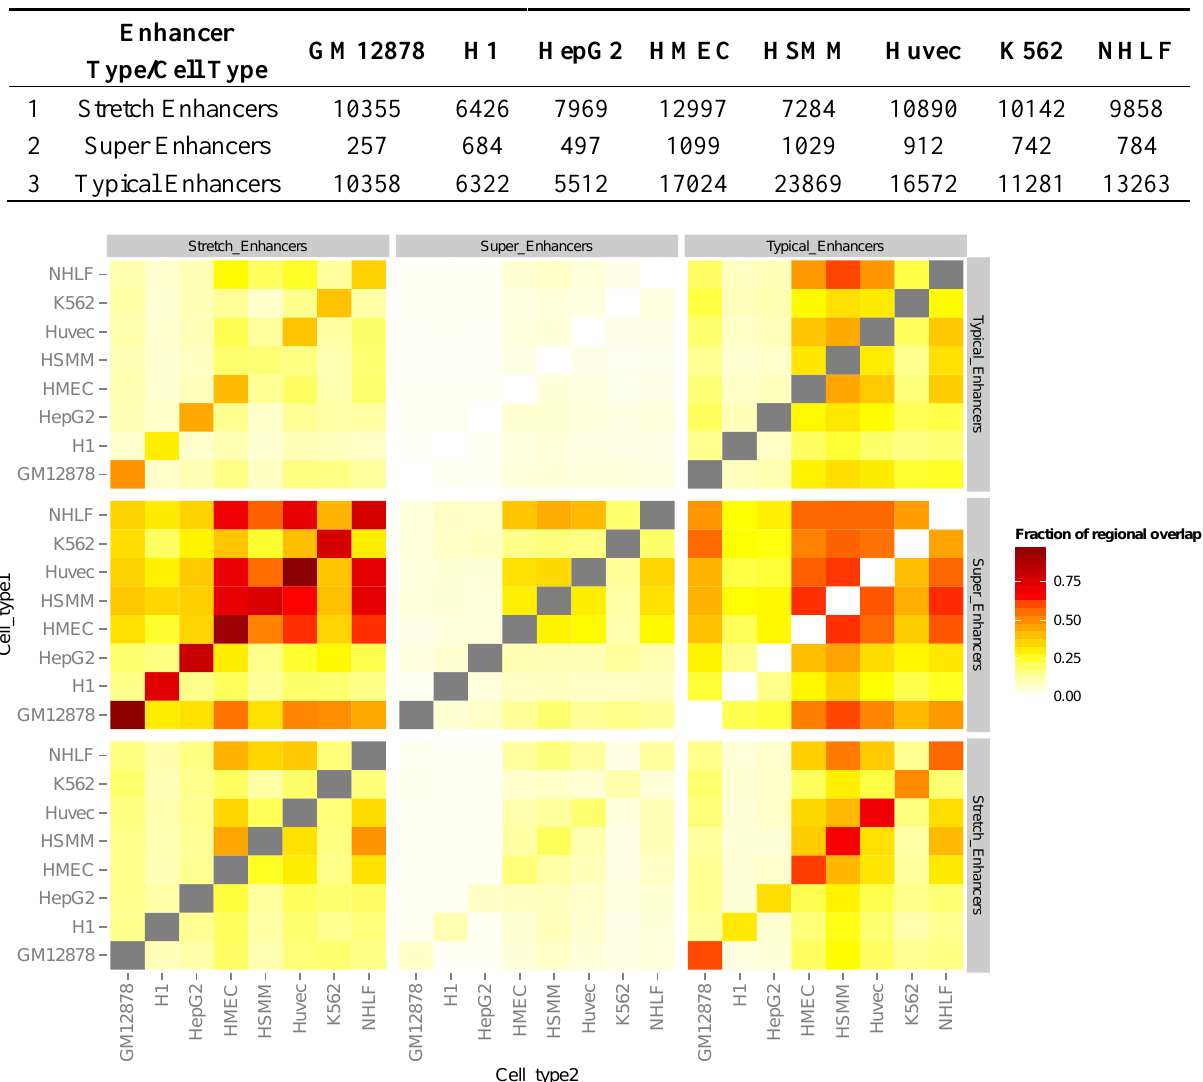
Figure 2. Regional overlap across enhancer classifications in eight matched cell types. Fraction of enhancers of the y-axis facet (cell type 1) that contain overlaps with enhancers of the x-axis facet (cell type 2) for each of the cell types. Note that fractional overlaps are calculated using total counts from cell type 1 in the denominator. Grey tiles denote overlaps of an element with